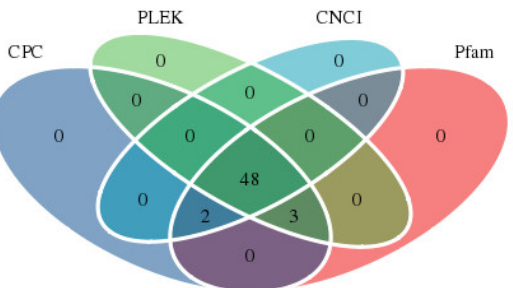
Figure 2. Statistics of lncRNA annotation in CPC, PLEK, CNCI and Pfam databases.